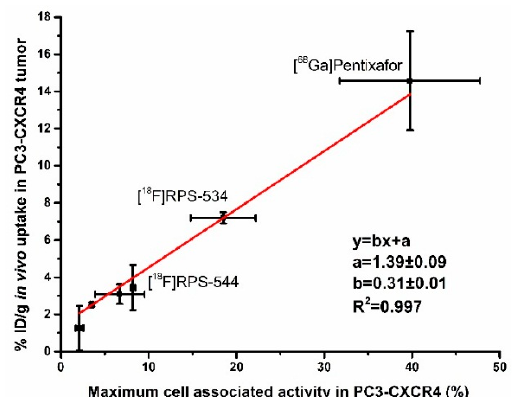
Figure 5. Correlation plot of the PC3-CXCR4 tumor uptake in vivo versus the PC3-CXCR4 cell-associated activity of the radioligands in vitro. Maximum cell-associated activity was calculated by subtracting the cell uptake at the highest non-radioactive ligand concentration of 10 µM from the cell uptake at the lowest non-radioactive ligand concentration of 10 − 5 µM. The equation of the linear fit and the correlation coefficient are reported.